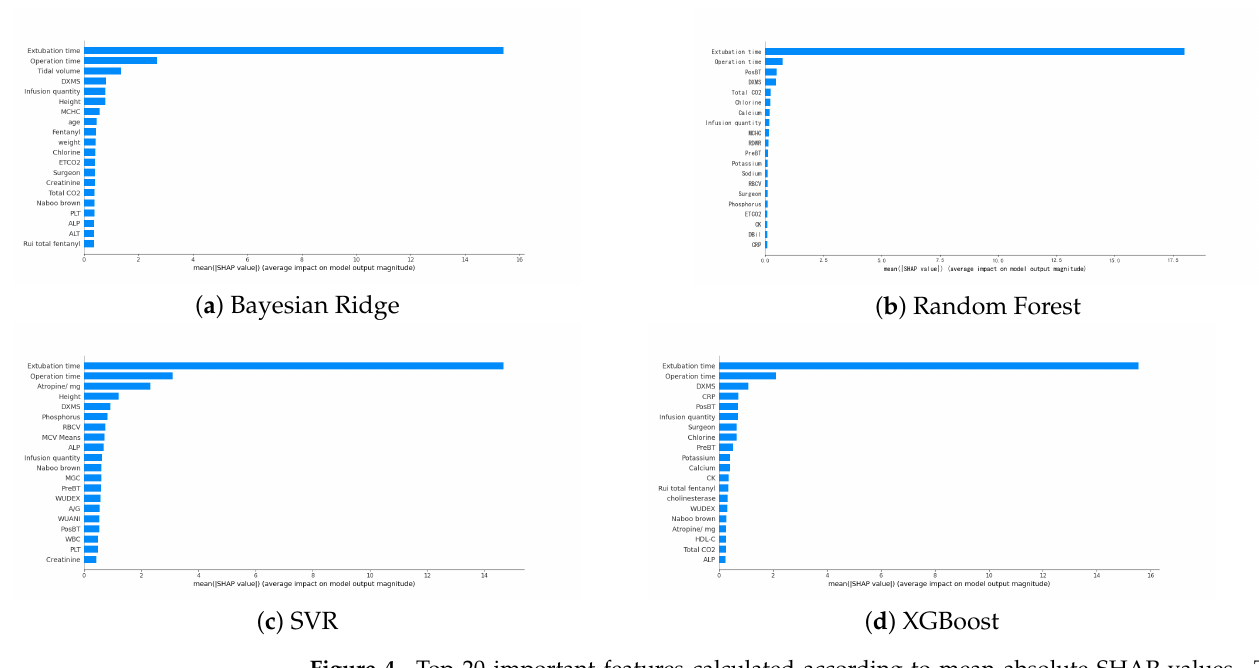
Figure 4. Top 20 important features calculated according to mean absolute SHAP values. The abbreviations in the figure are shown in Table A1 in the following abbreviations